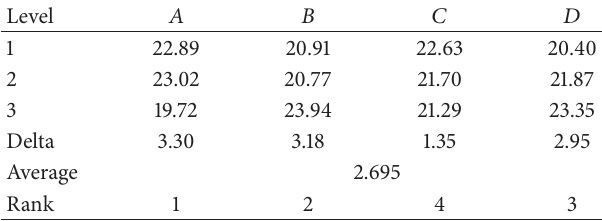
Table 3: S/N response table for